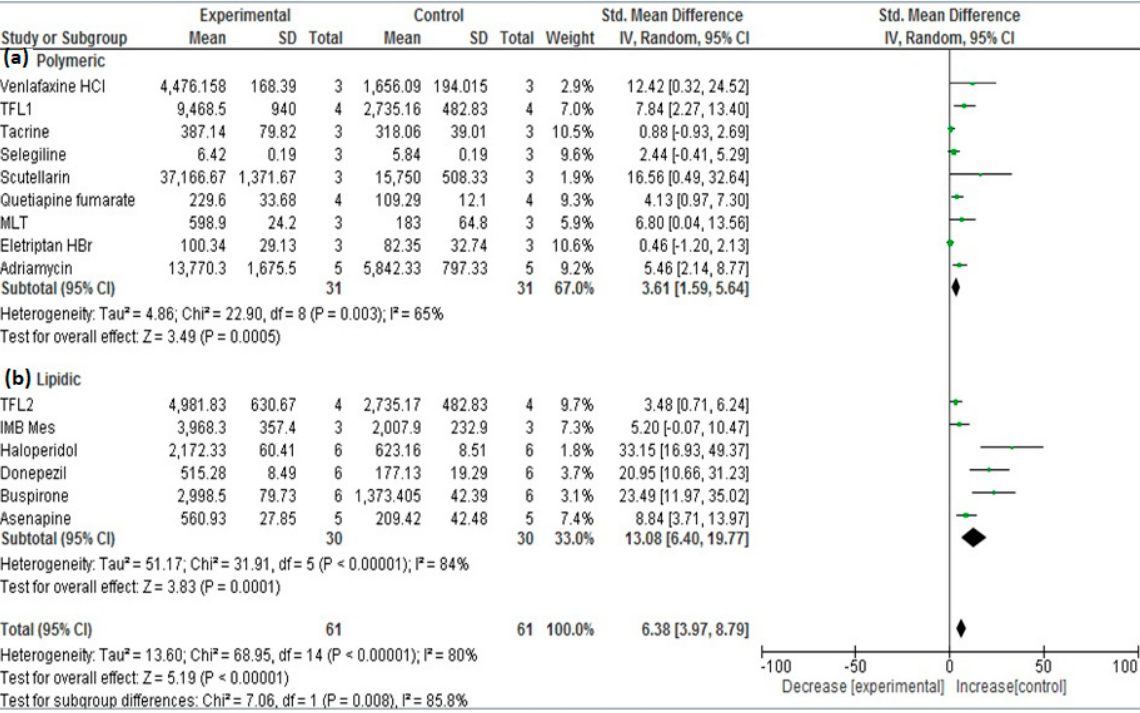
Figure 7. Forest plot of investigated subgroups: (a) polymeric nanoparticulate systems versus (b) lipid nanoparticulate systems for the studies: [1–3,5–8,11–17,19], (Review Manager results).